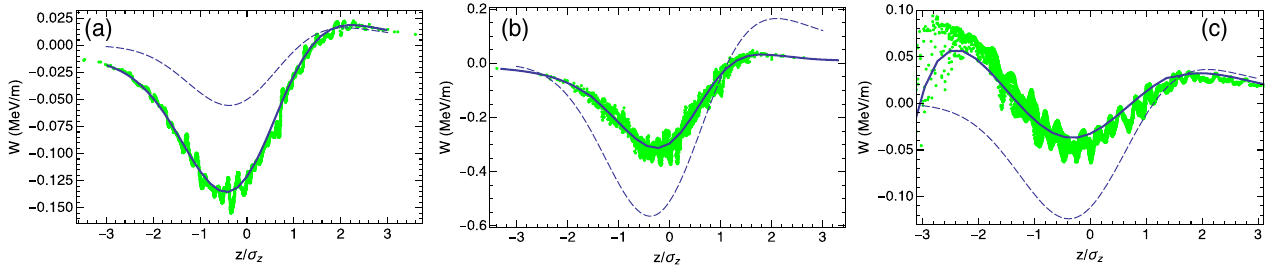
FIG. 3. Plots of the CSR wake along the semi major-axis of the beam, x ¼ z tan ξ , at three locations, (a) s ¼ 0 . 6 m, (b) s ¼ 0 . 8 m and (c) s ¼ 0 . 99 m, shown by solid lines; for comparison also shown by dashed lines is the CSR wake calculated using the 1D CSR model with a local value of σ z . The green dots show the CSR wakefield calculated with CSRTRACK . In each case the longitudinal coordinate z is normalized to the local value of σ z